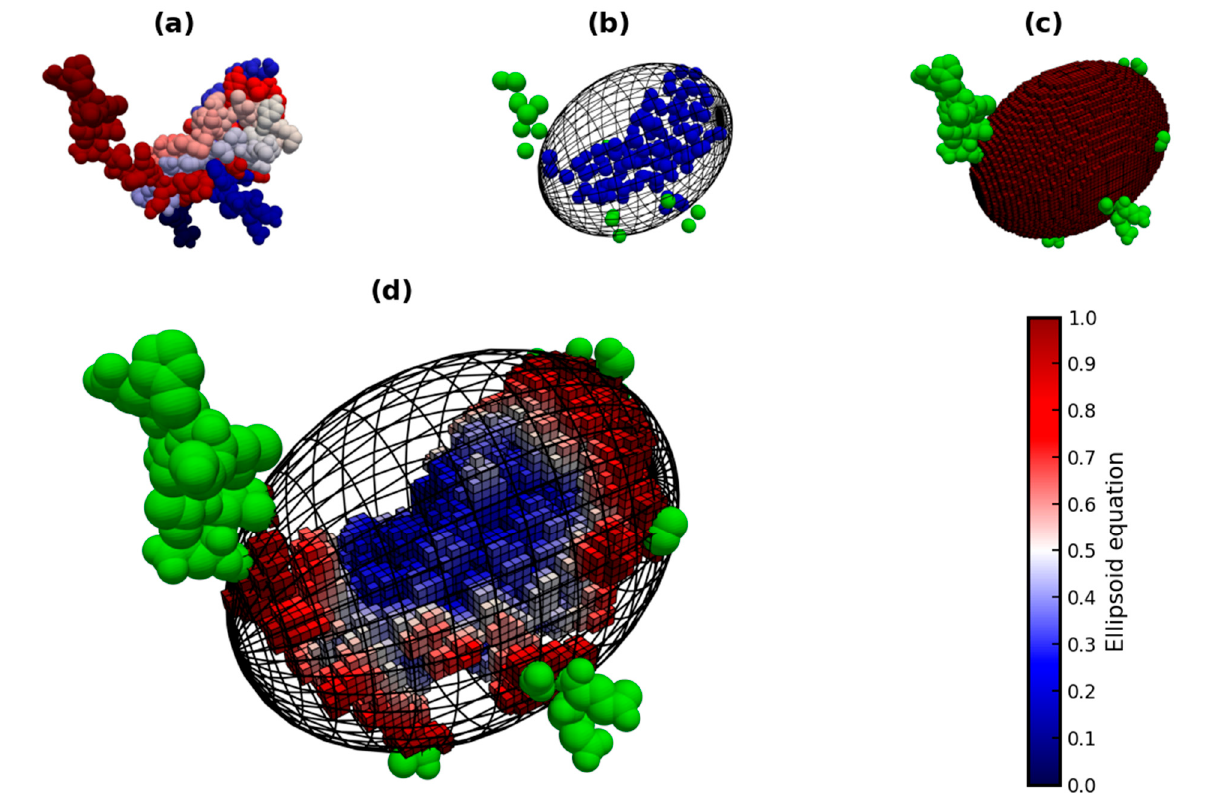
Figure 3. Four steps of application of EP algorithm to monomer of dUTPase YncF (4B0H). Step 1 ( a ): preparation of the structure with atoms shown as van der Waals spheres (blue—towards N-terminus, red—towards C-terminus). Step 2 ( b ): selection of effective atoms, separation of effective atoms into guide (blue) and outlier (green) subsets using m = 3, bounding in a minimum volume ellipsoid. Step 3 ( c ): alignment with axes of the coordinate system, generation of the grid. Step 4 ( d ): voxelization of the protein. Colors of voxels on ( d ) represent their matching values of Equation (1): blue—towards ellipsoid’s center, red—towards ellipsoid’s surface. Green spheres on ( c , d ) are atoms located outside the MVEE.